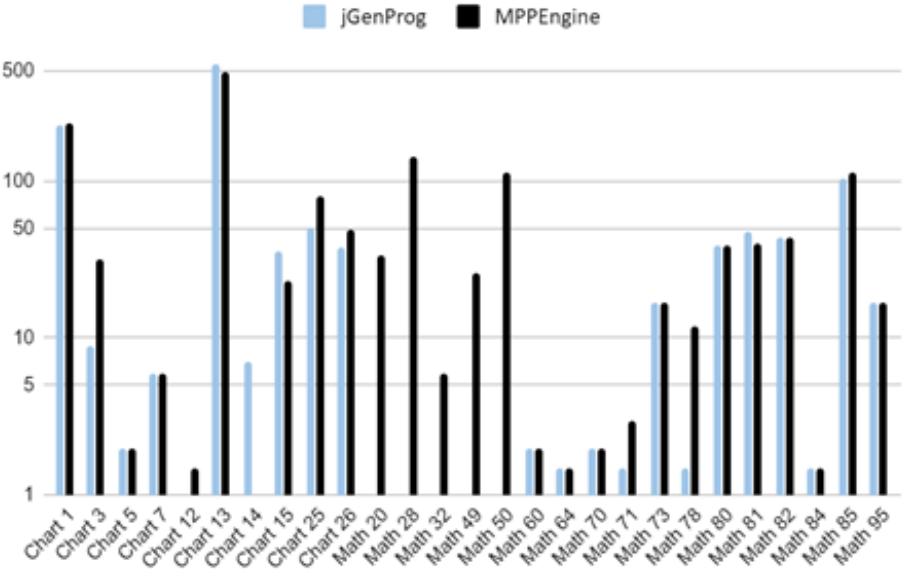
Figure 3. Number of patches generated per bug—jGenProg,